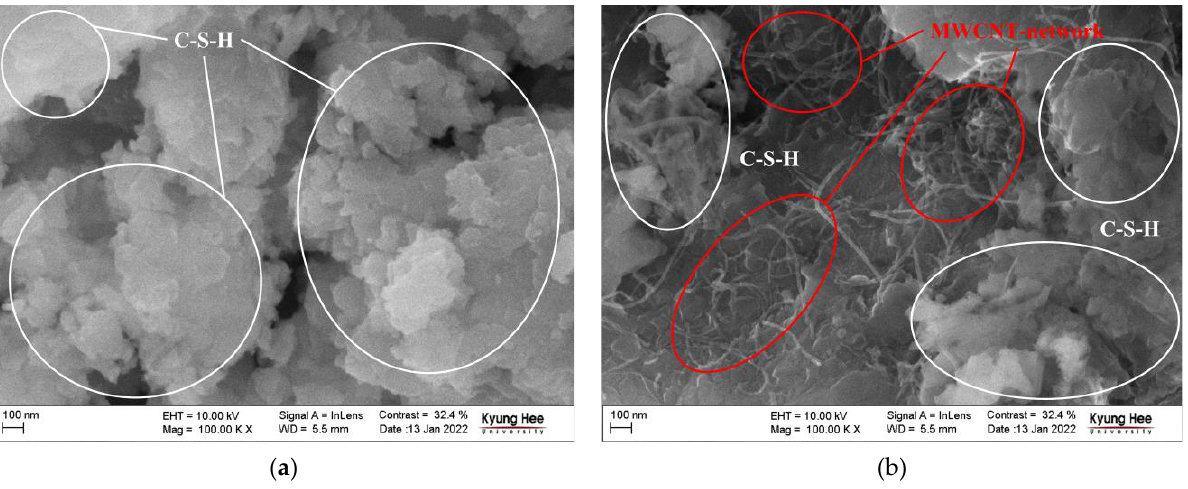
Figure 3. FE-SEM photograph of nano-cementitious composites: ( a ) MWCNT 0.0 wt%; ( b ) MWCNT 1.0